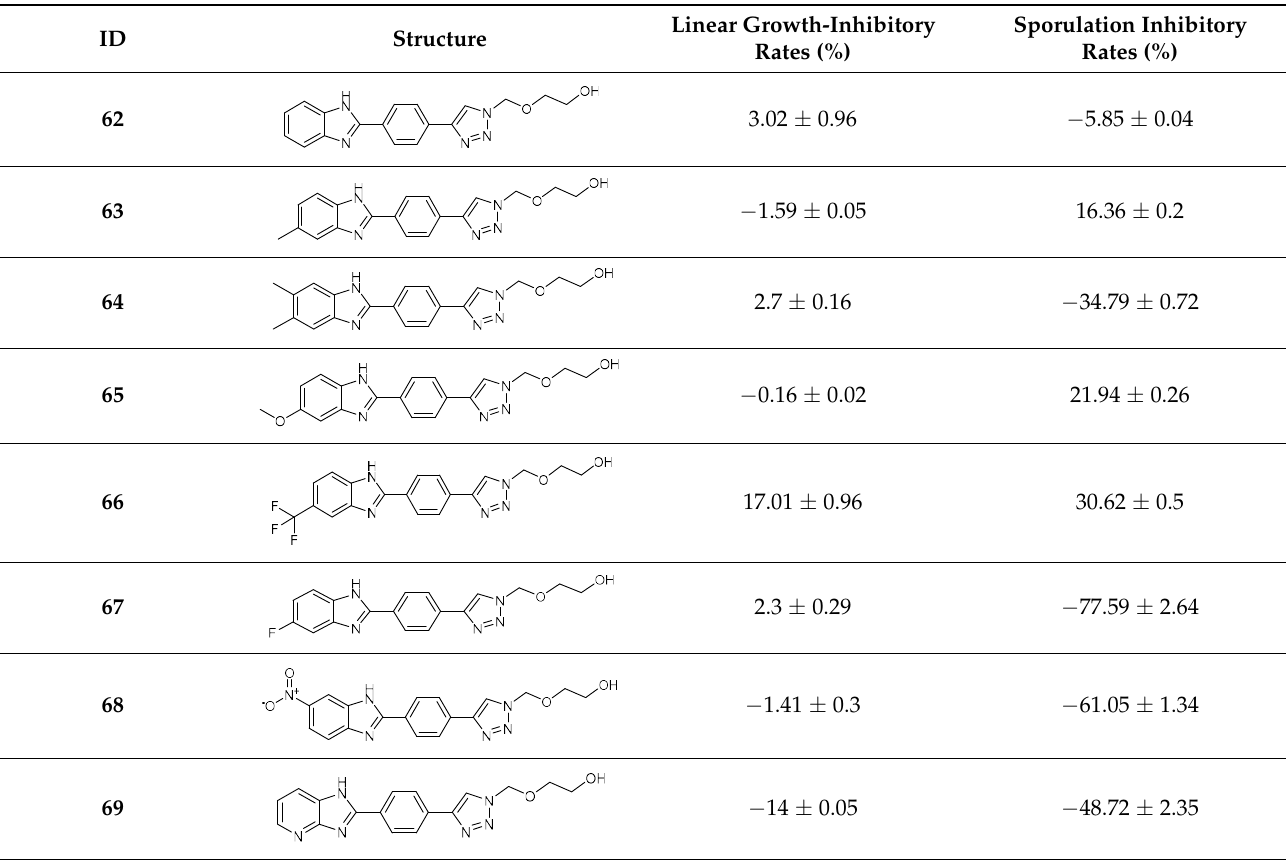
Table 8. Linear growth and inhibitory sporulation rates of benzimidazole-1,2,3-triazole hybrid molecules tested against F.o.a. Structure